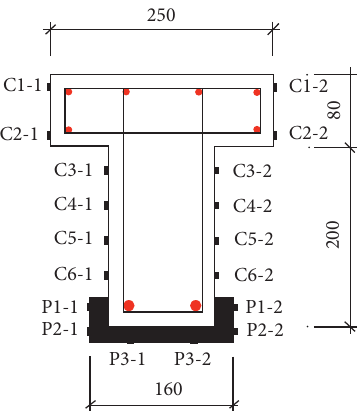
Figure 6: Test point layout schematic.